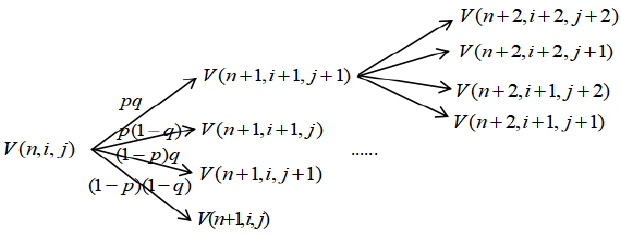
Figure 4. Stochastic decision process of PV investment project.